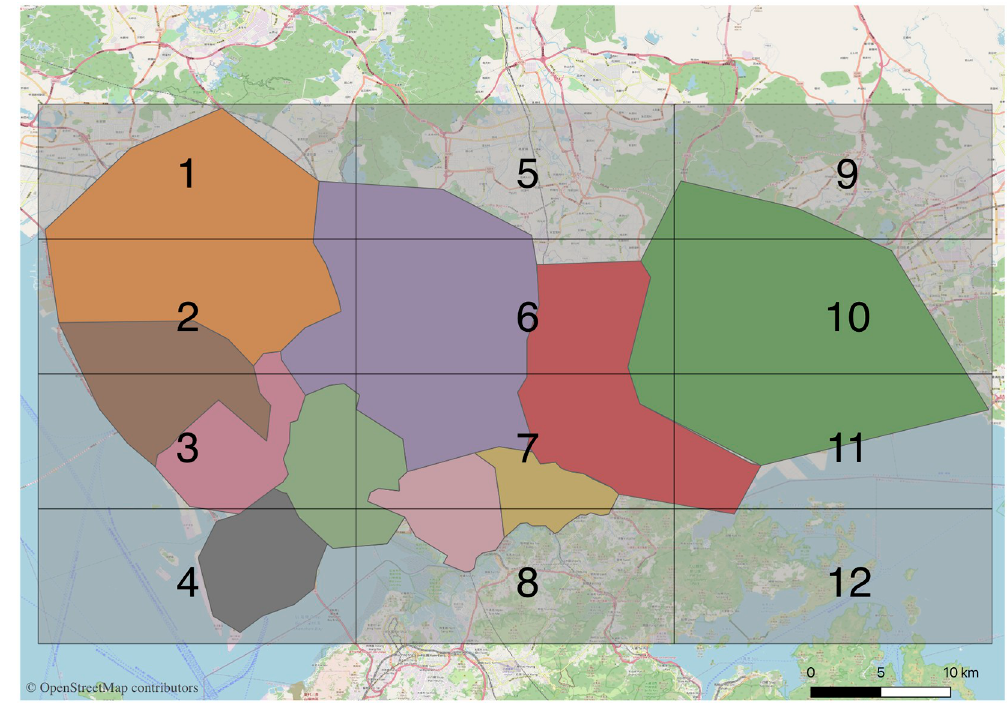
Fig 15. Grid zone division of the urban area in